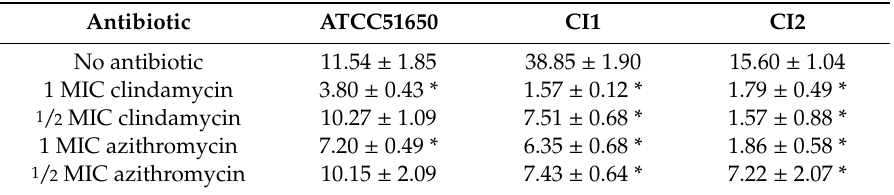
Table 3. Gray scale analysis of the SDS-page of 48-h biofilms with Image J. (compared with no antibiotic treatment, * p < 0.05, one-way ANOVA followed by LSD post hoc